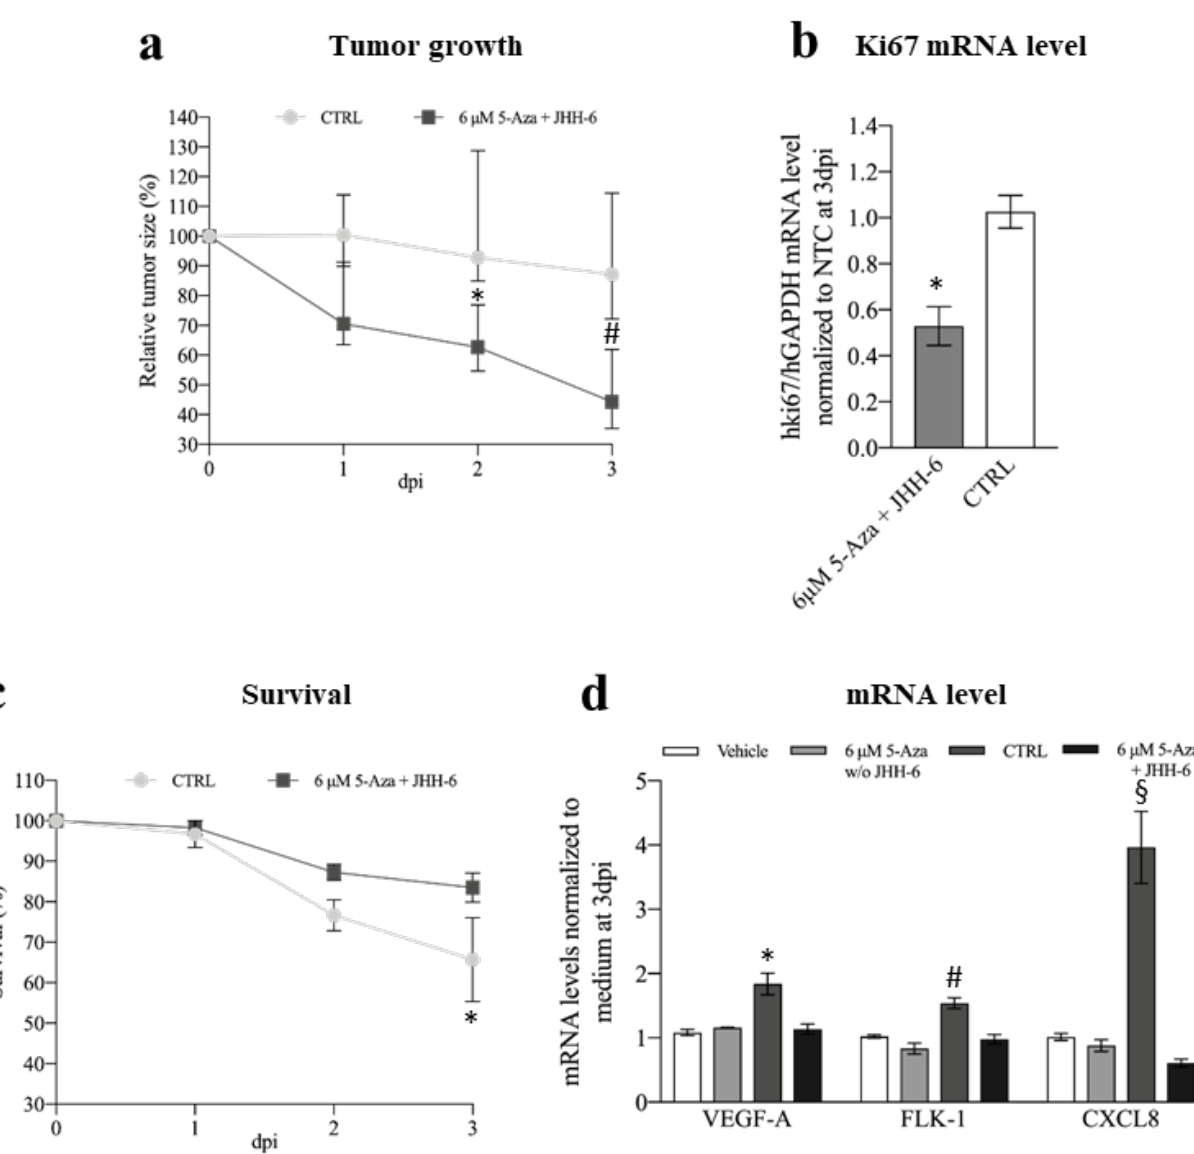
Figure 10. Phenotypic and molecular effects of 5-Aza in the xenograft zebrafish model of HCC. ( a ) Comparison of tumor growth between 5-Aza-treated and control zebrafish inoculated with JHH-6; data are reported in % as median with interquartile range, CTRL 2 days post-injection (dpi) vs. 6 µ M 5-Aza 2dpi, * p = 0.025; CTRL 3 dpi vs. 6 µ M 5-Aza 3dpi, # p = 0.0015, n = 45. ( b ) Effects of 5-Aza on human Ki67 mRNA level; data, normalized to GAPDH levels and to the average of CTRL, are reported as mean ± SEM, CTRL vs. 0.5 µ g 5-Aza * p = 0.0002, n = 12. ( c ) Kaplan–Meier curve; zebrafish were treated either with 0.5 µ g 5-Aza/day or with saline solution (CTRL), log-rank (Mantel–Cox) test, * p = 0.0252, n = 45 for each group; % of animal survival is expressed as mean ± SEM, n = 45. ( d ) Effects of 5-Aza on the zebrafish VEGFA, FLK-1, and CXCL8 mRNA levels (vehicle: animal not injected with JHH-6 and treated with saline; 6 µ M 5-Aza w / o JHH-6: animal not injected with JHH-6 and treated with 5-Aza; CTRL: animal injected with JHH-6 and treated with saline; 6 µ M 5-Aza + JHH-6: animal injected with JHH-6 and treated with 5-Aza). Data, normalized to GAPDH levels and to the average of CTRL at 3dpi, are reported as mean ± SEM. VEGFA: CTRL vs. 6 µ M 5-Aza + JHH-6, * p = 0.0359; FLK-1: CTRL vs. 6 µ M 5-Aza + JHH-6, # p = 0.0495; CXCL8: CTRL vs. 6 µ M 5-Aza + JHH-6, § p < 0.0001, n =